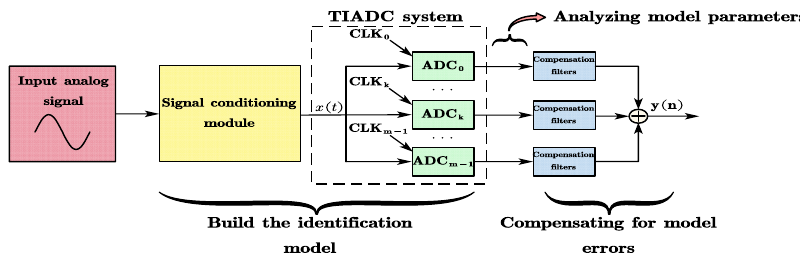
Figure 2. Working Mechanism of TIADC Error Correction System Based on Parameter Estimation of Identification Model.